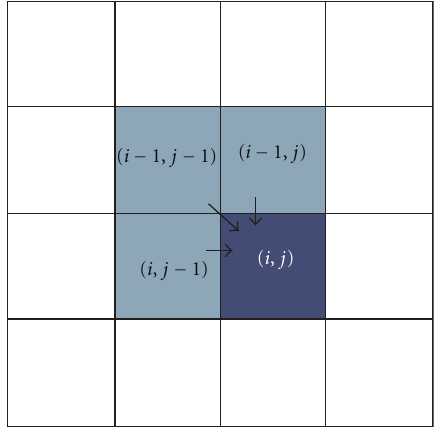
Figure 4: The data dependencies in the Smith-Waterman algorithm